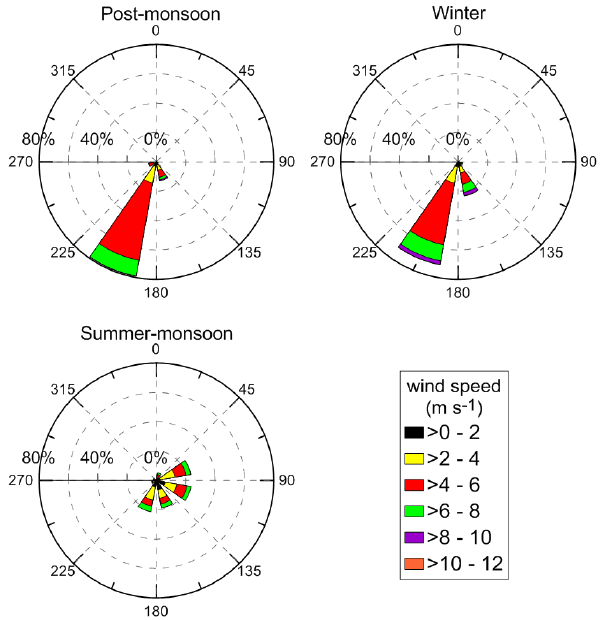
Figure 9. WD and u (half-hourly means) at AWS1 for post- monsoon, winter- and summer-monsoon representative periods. The frequency of WD is expressed as percentage over the entire observational period (indicated on the radial